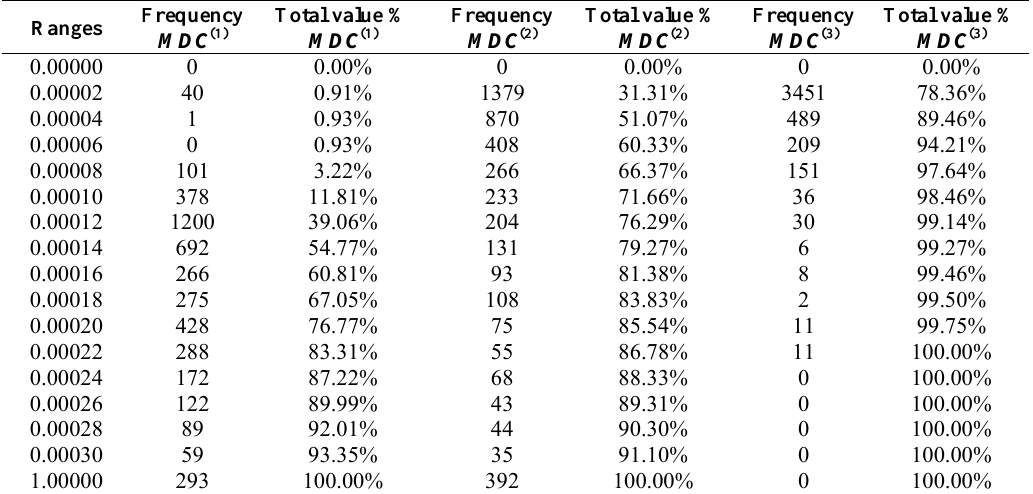
Table 5 Histogram and accumulative percentage distribution of MDC (1) , MDC (2) , MDC (3) for given ranges